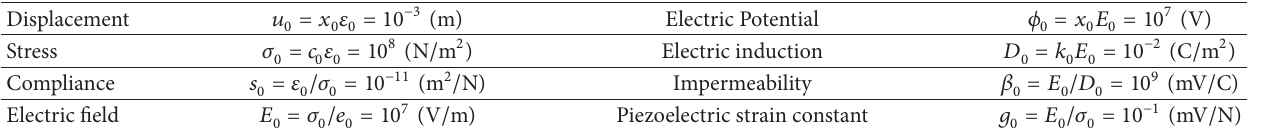
Table 1: Reference values for material constants and field variables in piezoelectricity derived from basic reference variables: 𝑐 0 , 𝑒 0 , 𝑘 0 , 𝜀 0 , and 𝑥 0